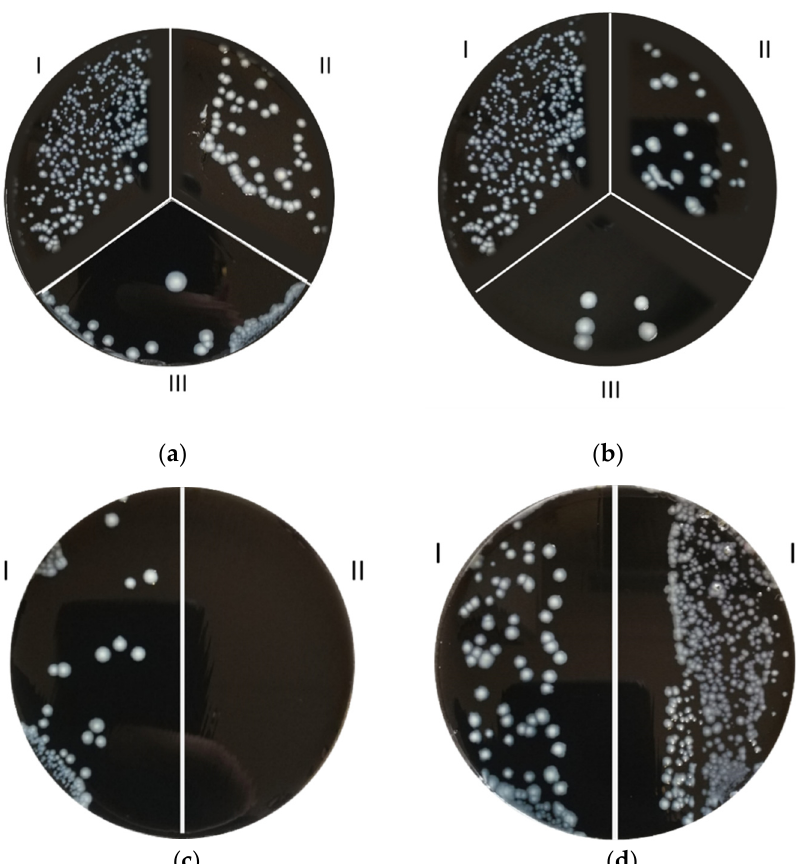
Figure 5. Colony density of L. pneumophila in starting ( aI , bI ) and filtered water samples: 50 mL sample after 1 ( aII ) and 5 ( aIII ) filtrations with PP filter; 50 mL sample after 1 ( bII ) and 5 ( bIII ) filtrations with s-PBC@PP filter; 200 mL sample after 6 filtrations with PP ( cI ) and s-PBC@PP ( cII ) filter. Colony density of total L. pneumophila blocked on PP ( dI ) and s-PBC@PP ( dII ) filter surface.